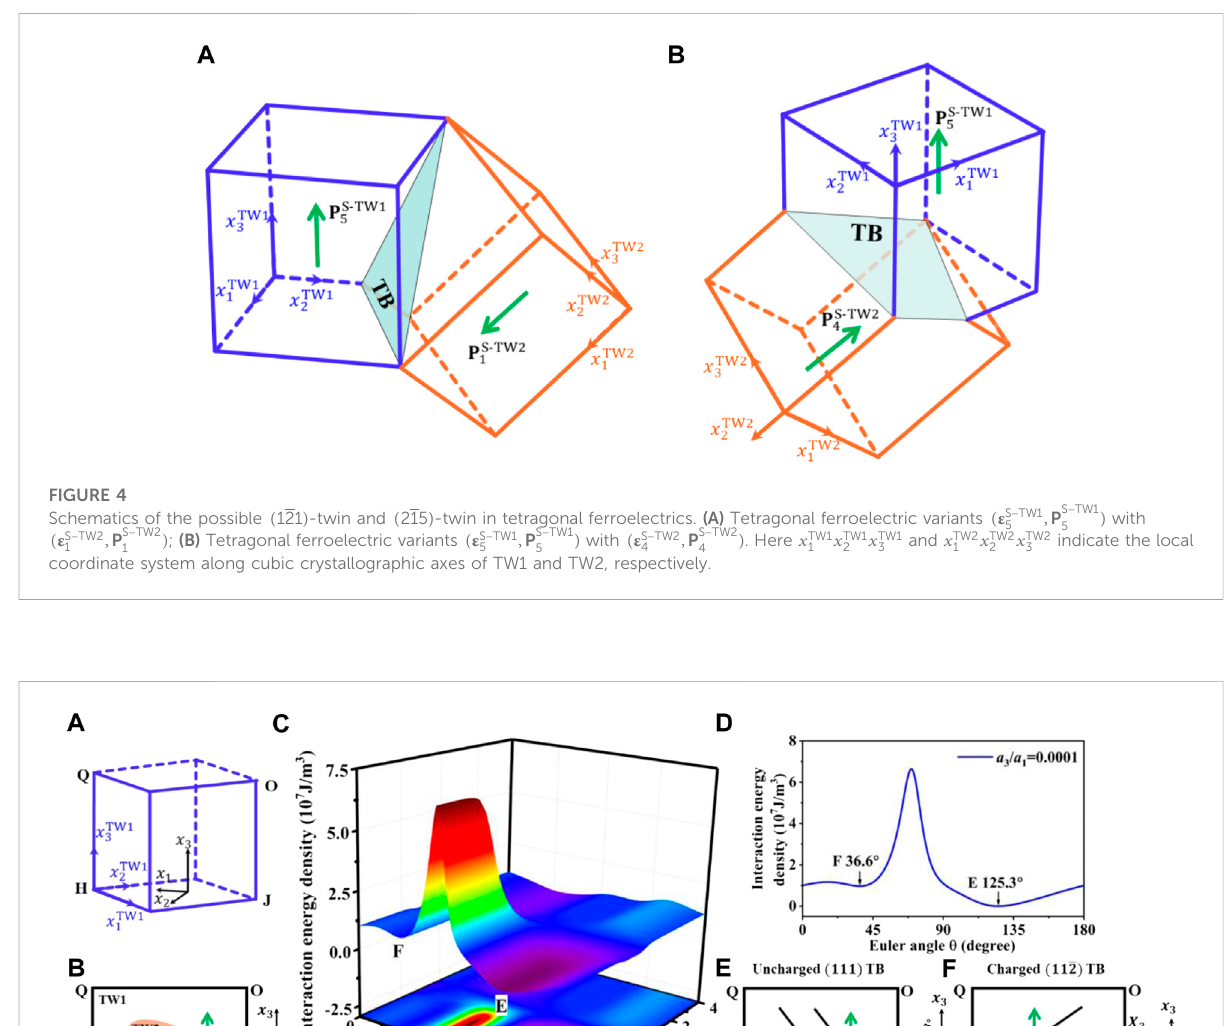
FIGURE 5 Energetic analysis of twinned structure with variants ( ε S − TW1 5 , P S − TW1 5 ) and ( ε S − TW2 5 , P S − TW2 5 ) : (A) Schematic of the relationship between the global coordinatesystem x 1 x 2 x 3 andlocalcoordinatesystem x TW1 1 x TW1 2 x TW1 3 ; (B) Schematicofvariant ( ε S − TW2 5 , P S − TW2 5 ) asaninhomogeneousinclusionwithin ) as the matrix; (C) the potential energy variation as a function of the shape aspect ratio a the variant ( ε S − TW1 5 , P S − TW1 5 inhomogeneous inclusion TW2; and (D) the corresponding potential energy variation at a 3 / a 1 = 0.0001; The schematics of the uncharged (E) and charged (F) twin boundaries corresponding to the two wells in the energy